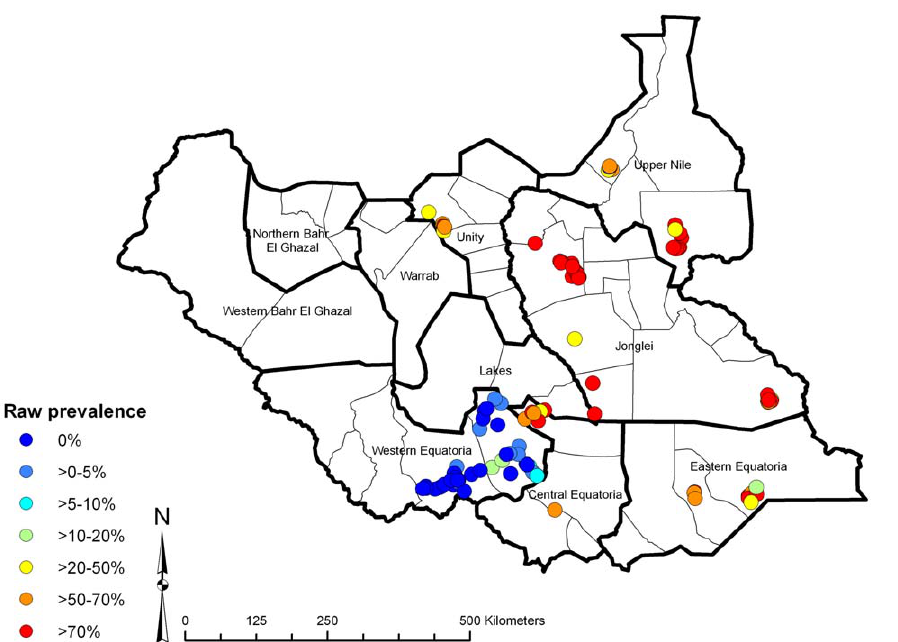
Figure 1. Observed prevalence of active trachoma using data from population-based prevalence surveys, in children aged 1–9 years, Southern Sudan, 2001–2009.